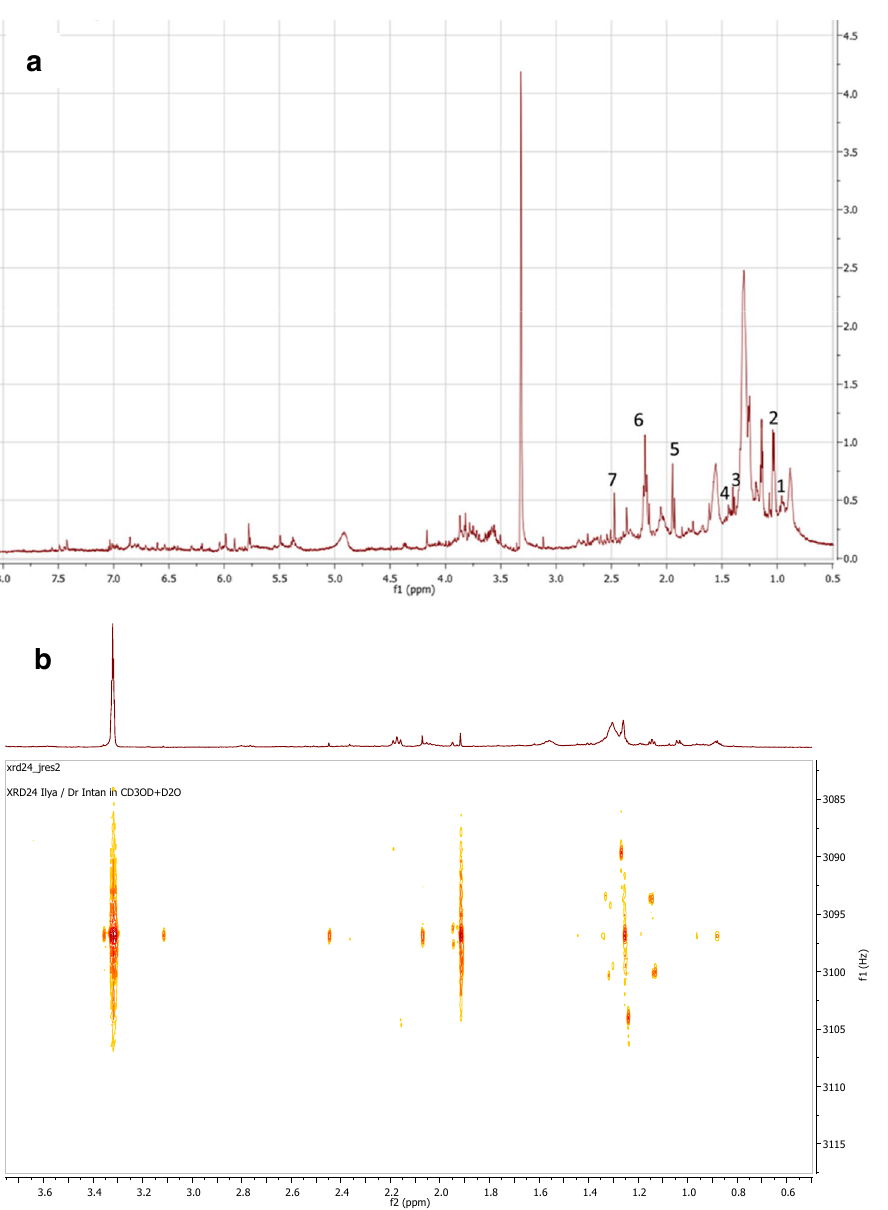
Figure 3. NMR Spectroscopy result from X. granatum ethyl acetate extract. ( a ) 1D 1 H NMR (CD 3 OD + D 2 O, 500 MHz) δ 0.94 (d, J = 7.0 Hz, isoleucine), 1.03 (d, J = 6.1 Hz, valine), 1.39 (d, J = 6.7 Hz, lactic acid),